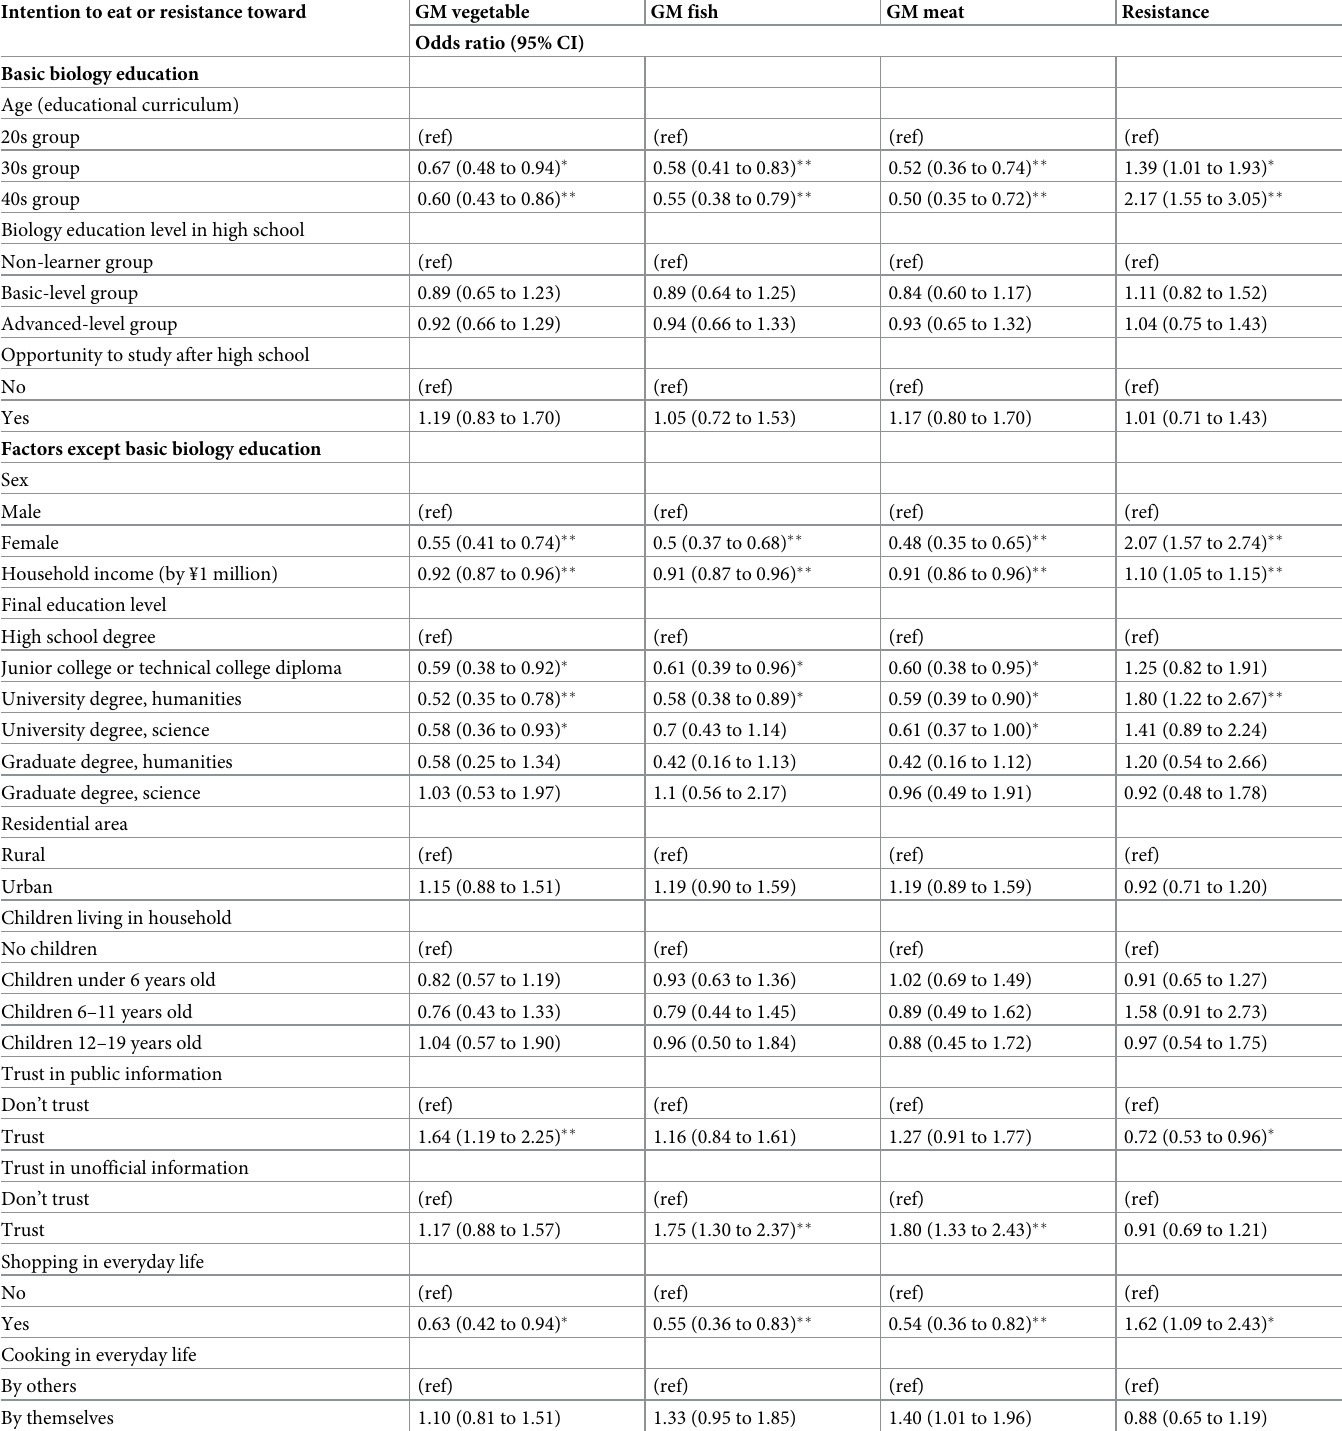
Table 8. Odds ratios of logistic regression analysis explaining acceptance of GM food according to basic biology education, sociodemographic characteristics, trust in institutions, and practices of everyday